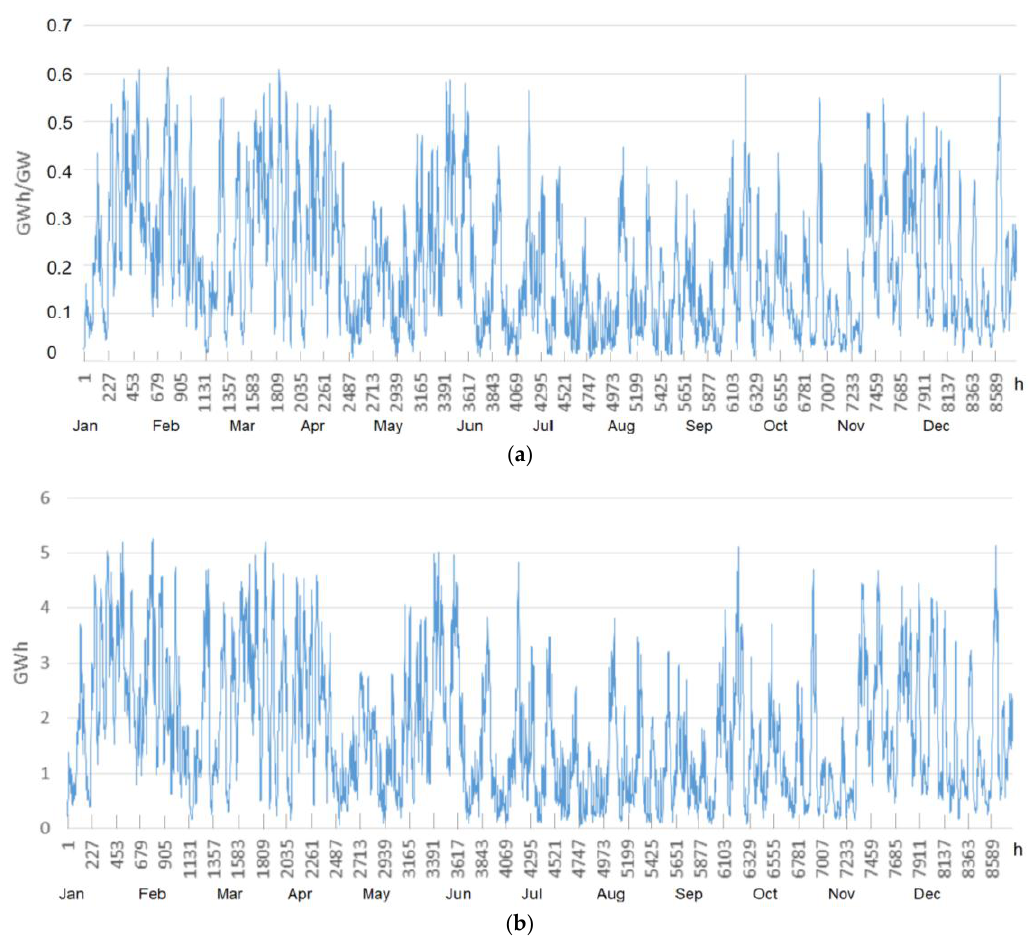
Figure 7. ( a ) Hourly wind production trend and ( b ) specific hourly distribution of wind power in Italy. Geothermal